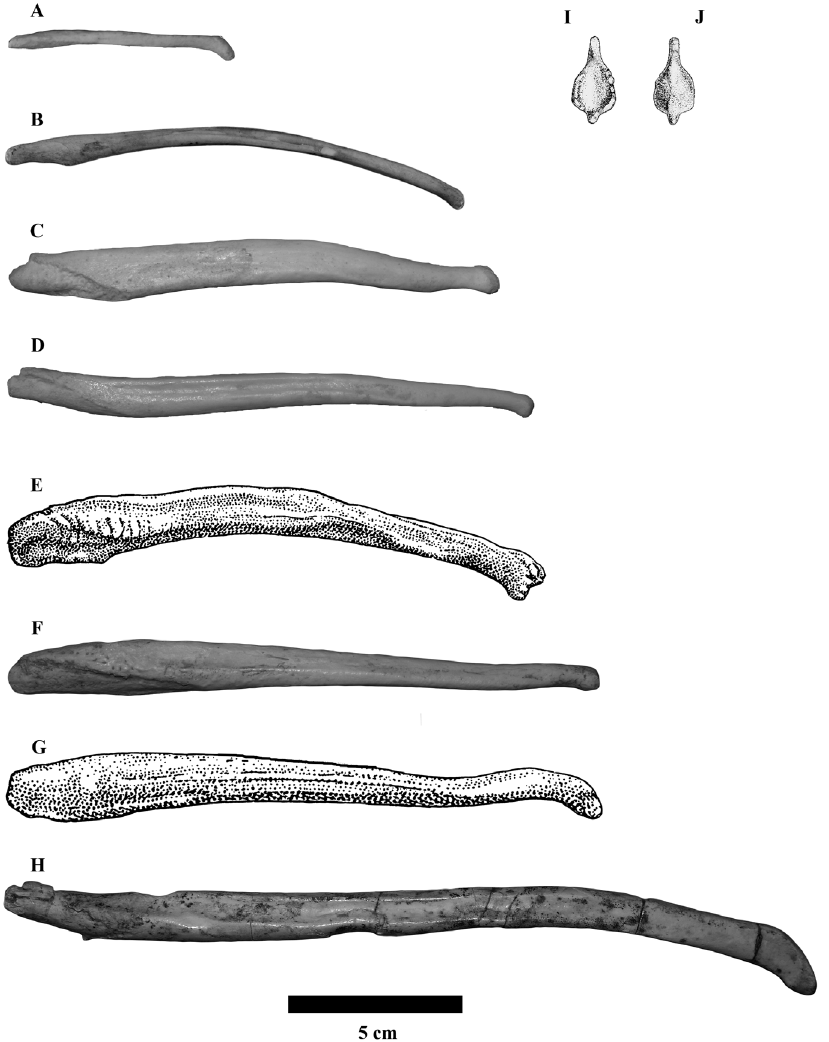
Figure 1. Modified from Didier 1950 and Davis 1964. Baculum in laterial view of: A Helarctos malayanus; B Ursus thibetanus; C Tremarctos ornatus; D Ursus americanus; E Melursus ursinus; F Ursus arctos; G Ursus maritimus; H Indarctos arctoides; I Ventral view of the Baculum of Ailuropoda melanoleuca; J Dorsal view of the baculum of Ailuropoda melanoleuca.